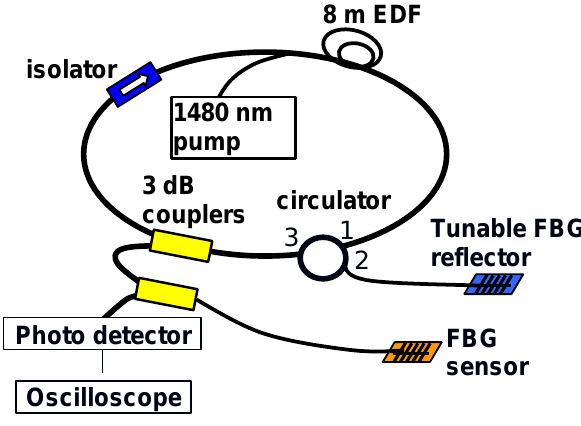
Figure 4. Interrogation scheme based on a ring laser.